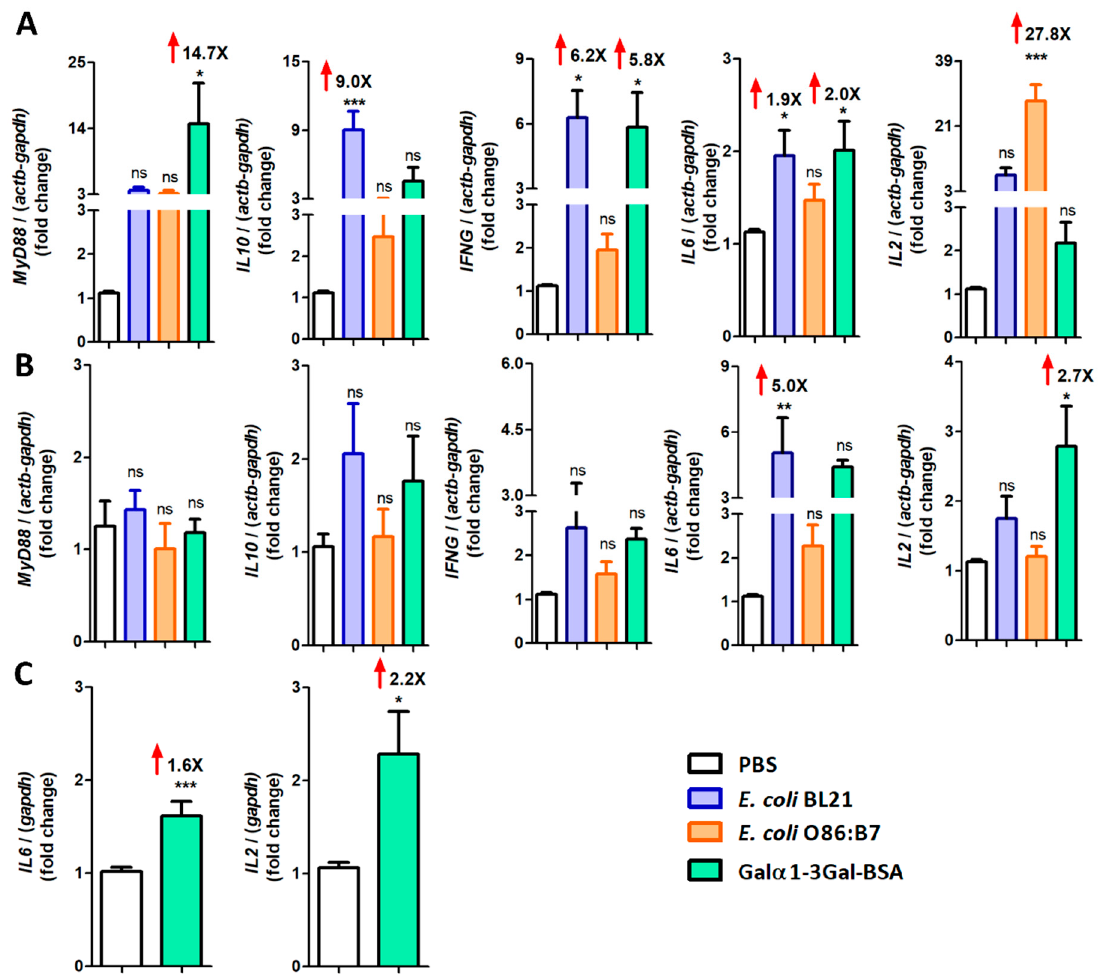
Figure 7. Expression of turkey and chicken cytokine genes in response to oral administration of E. coli O86:B7 and E. coli BL21 and α -Gal-BSA immunization. The figure displays the mRNA expression levels of INF γ , IL6 , IL2 , IL10 and MyD88 in ceca ( A ) and lungs ( B ) of turkeys and IL6 and IL2 in lungs of chicken ( C ). Total RNA was extracted and gene expression levels were measured by qPCR normalizing against turkey actb and gapdh as housekeeping genes, using the using the 2 − ∆∆ C t ratio method. Expression levels are relative to the control group (i.e., PBS). Results shown are means and standard deviation values. Results were compared by One-way ANOVA with Dunnett’s multiple comparison test applied for individual comparisons (* p < 0.0001, ** p < 0.001, *** p < 0.0001; ns: not significant, the magnitude of significant fold changes compared with the PBS are shown (red arrows), 1 experiment with chicken, n = 10 and 2 experiments with turkeys, n = 40 and three technical replicates per sample).